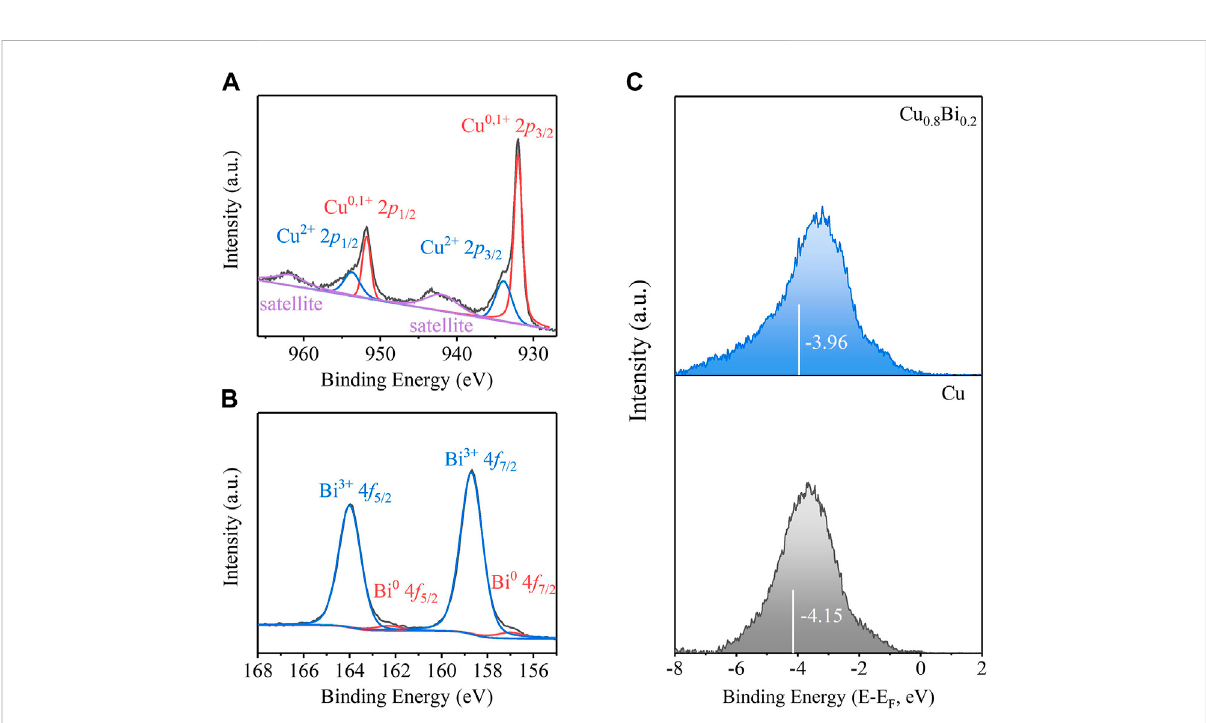
FIGURE 2 (A) SEM images of the synthesized Cu Cu 0.8 Bi 0.2